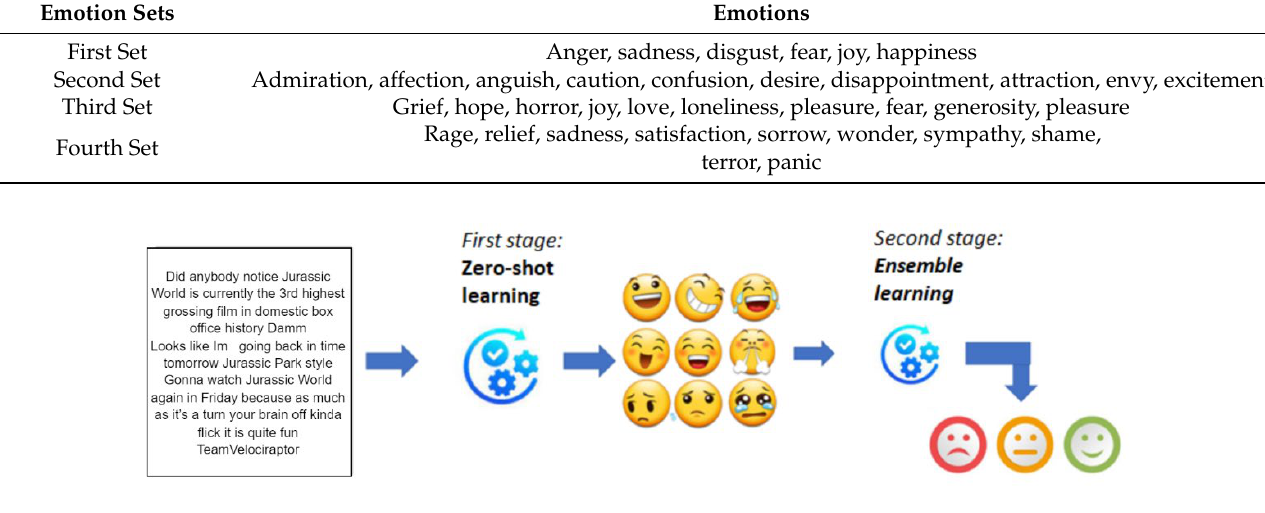
Figure 1. Workflow of the proposed semi-supervised method for sentiment classification. It includes two stages (phases), which combine unsupervised classification for recognizing emotions in a text, and supervised classification for detecting sentiments from emotions. Table 3. Set of emotions used for zero-shot classification.